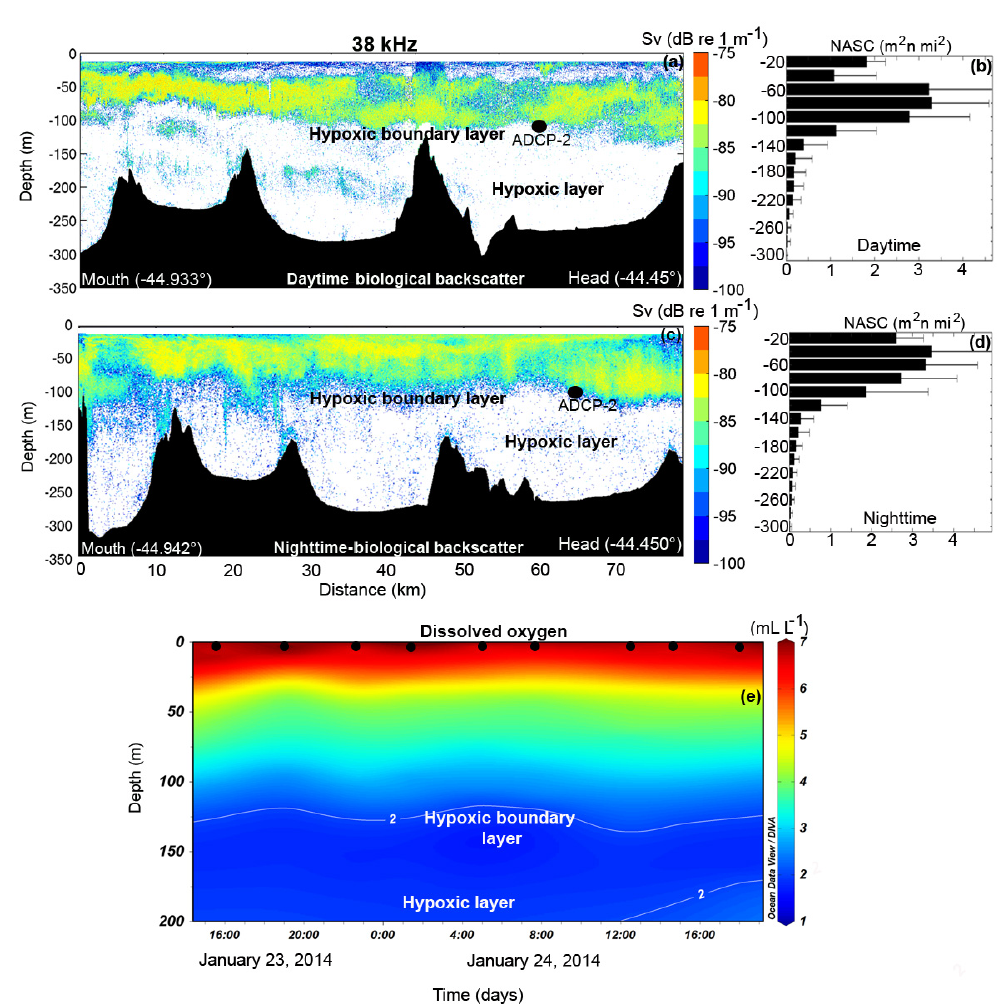
Figure 5. Single-frequency (38kHz) scientific echo-sounder transect conducted along the Puyuhuapi Fjord during the summertime field cam- paign (January 2014). Distribution indicated by colors representing S v . (a) Daytime transect of echo-sounder measurements ( S v ) throughout depth ( y axis) from the mouth (0km) to the head (80km) of Puyuhuapi Fjord on 22 January 2014. (b) Average profiles derived from the nautical area scattering coefficient (NASC) from the daytime transect with standard deviation bars. (c) Same as (a) , but for the nighttime starting at 21:57 (local time) 24 January through early in the morning of 25 January 2014. (d) Same as (b) but for the nighttime. The ADCP-2 mooring location is marked with a black dot in (a) and (c) . (e) Dissolved oxygen profiles (black dots) obtained approximately every 3h (close to the position of ADCP-2 mooring) from 23 to 24 January 2014. The location of the hypoxic boundary layer is depicted by the white contour line of 2mLL − 1